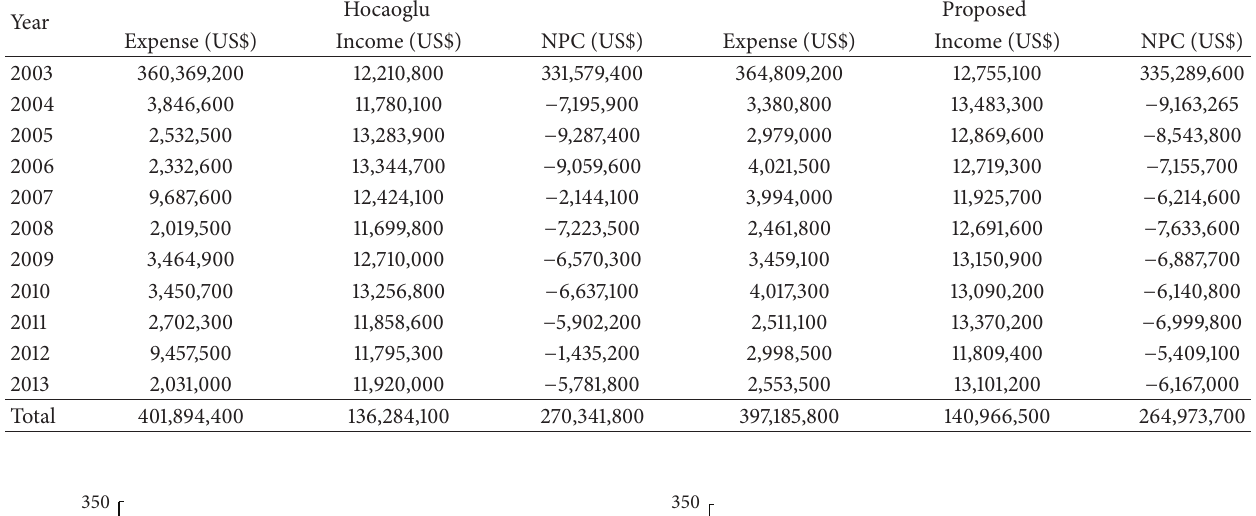
Table 5: The comparison of cost detail.